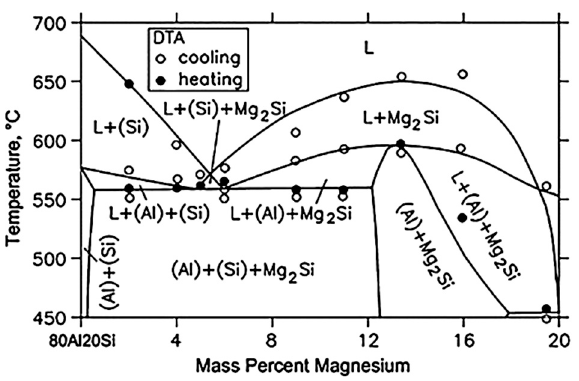
Figure 2. The phase diagram of Al-Mg-Si computed vertical section [32]. Copyright 2007 Springer.